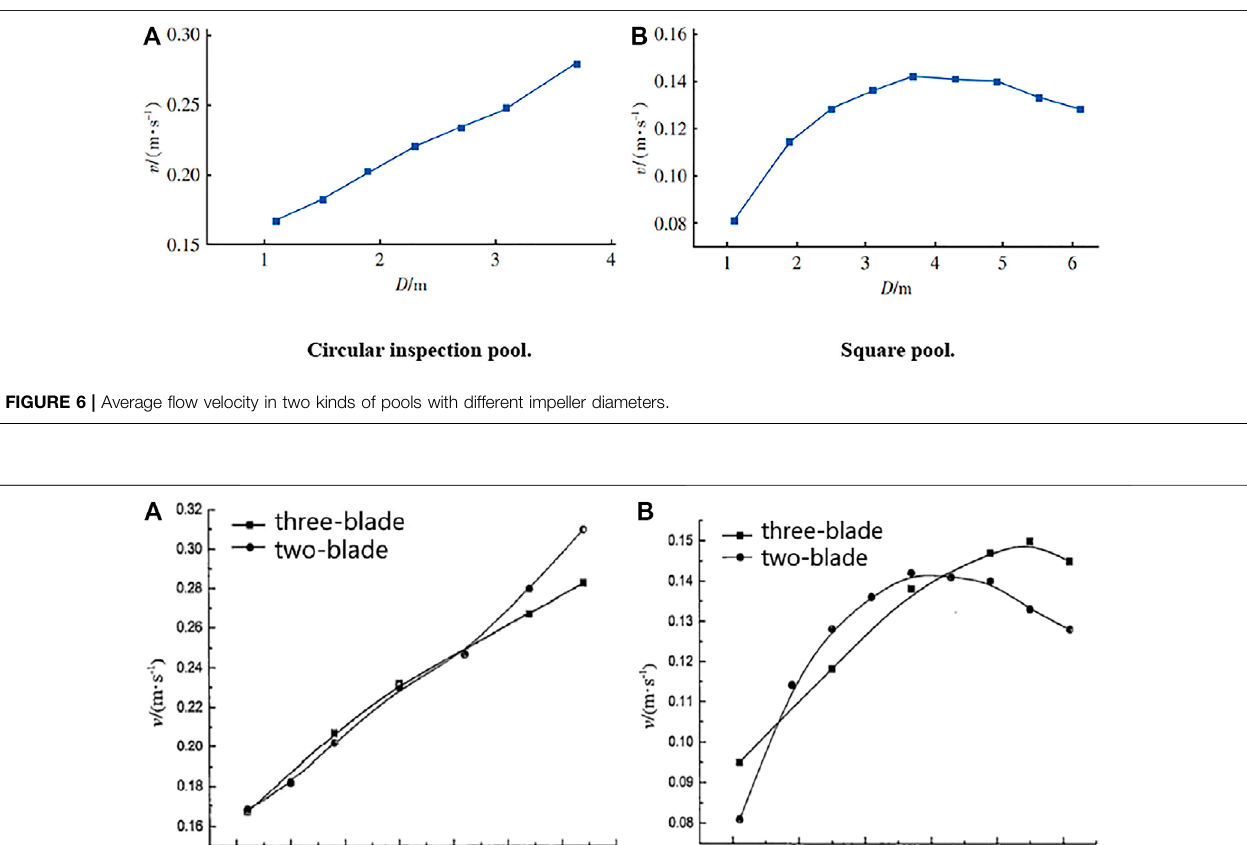
Frontiers in Energy Research |